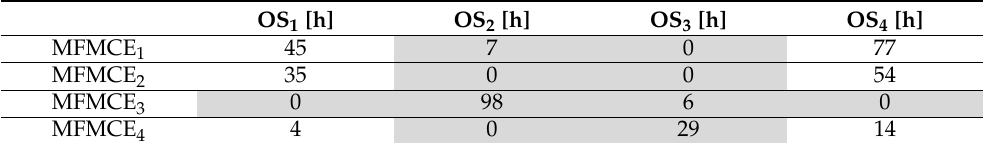
Table 6. Cross combination with additional zeros.